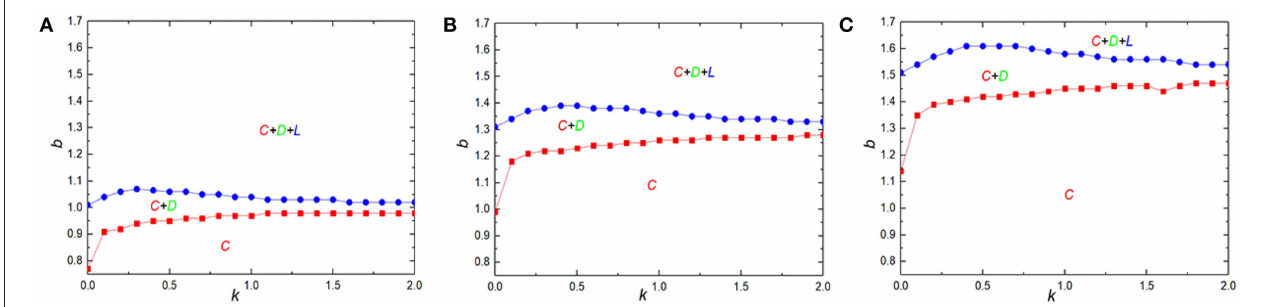
FIGURE 8 | Full b − K phase diagrams for β = 0.0 (A) , β = 0.3 (B) , and β = 0.5 (C) from left to right. Red curve represents the boundary of defector extinction, and the blue curve stands for the boundary of the emergence of